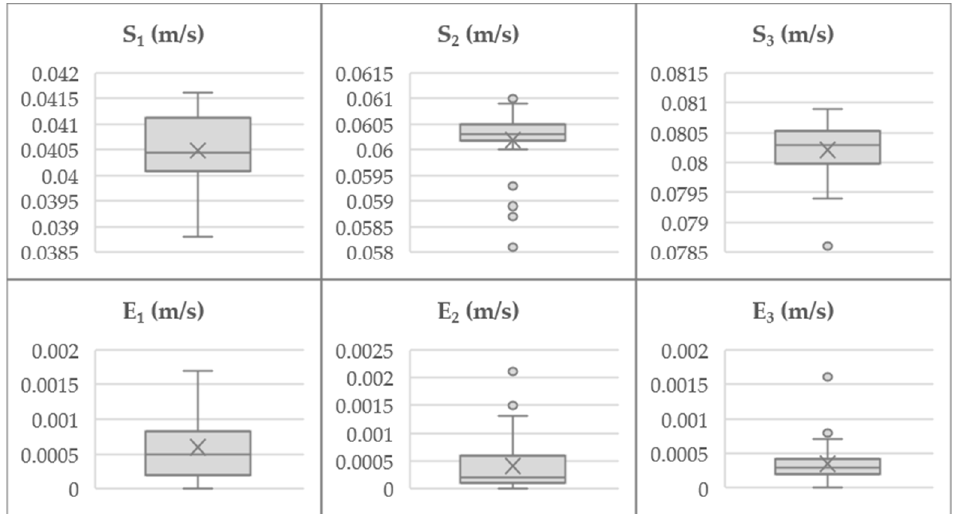
Figure 9. Controlled speed measurements and absolute error calculation.